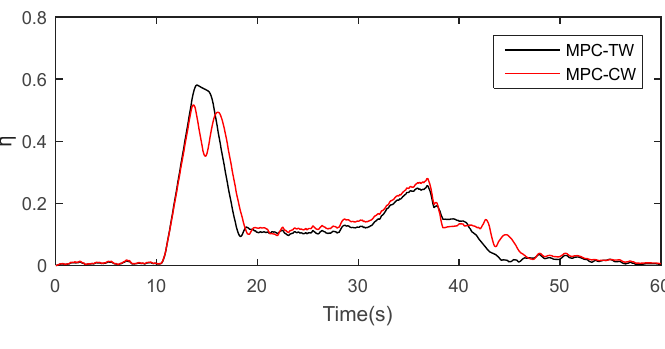
Figure 12. Adhesion workload.